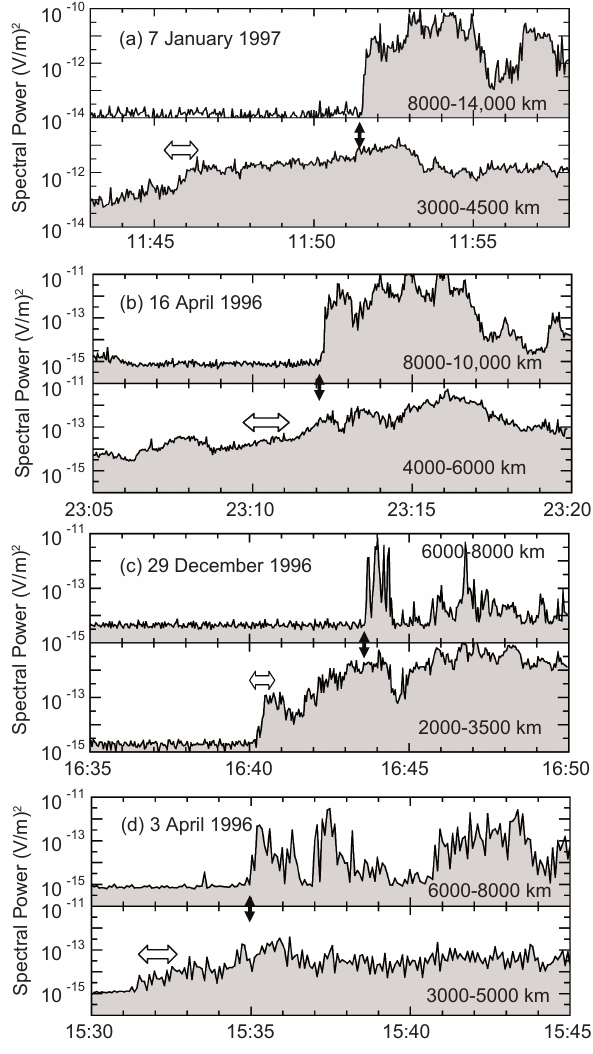
Fig. 6. Height-integrated power profile of AKR for the four sub- storms represented in Figs. 1, 2, 4, and 5. The upper and lower traces of each panel indicate power profile of high-altitude and low- altitude AKR, respectively. Altitude range for height-integration is shown in each panel. Horizontal and vertical arrows in each panel indicate rise of low-altitude AKR and onset of high-altitude AKR,